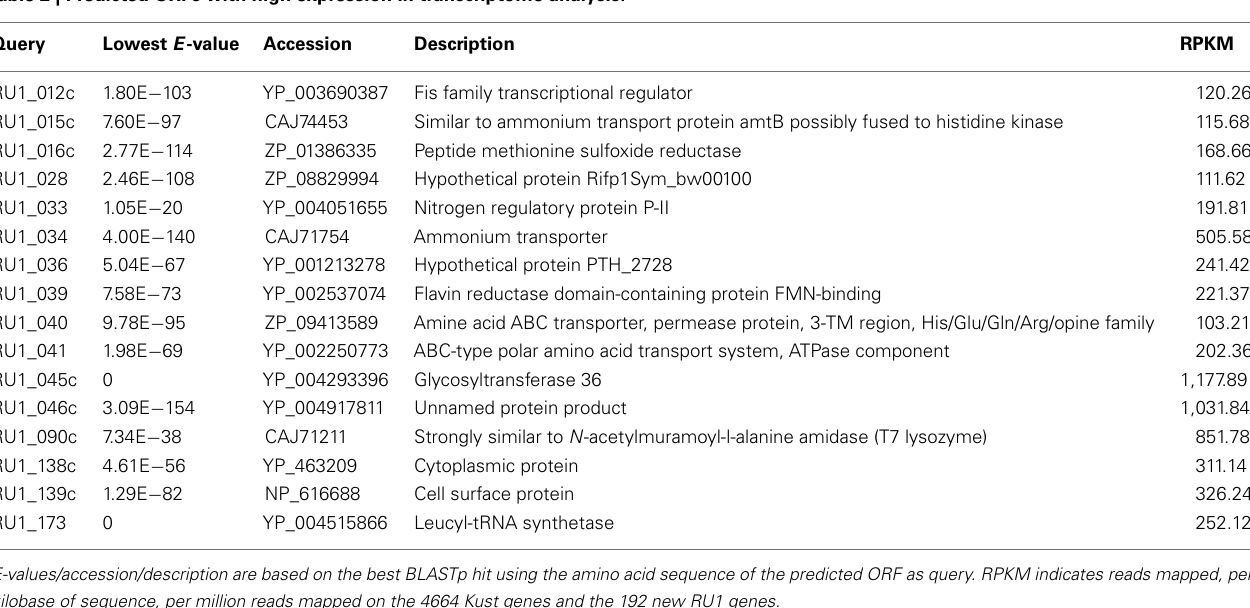
Table 2 | Predicted ORFs with high expression in transcriptome analysis.